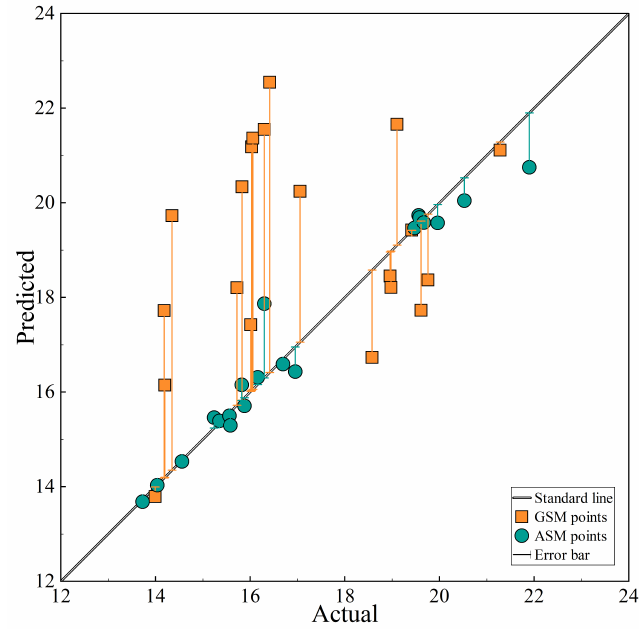
Figure 12. Comparison of ˆ σ error between GSM and